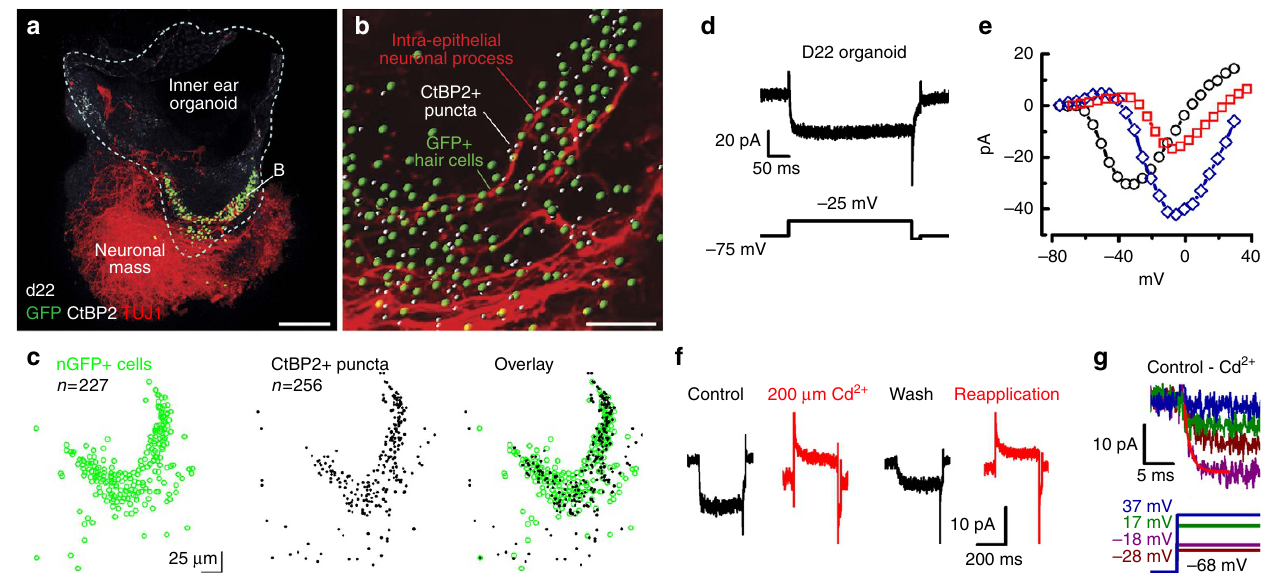
Figure 5 | Atoh1/nGFP organoid hair cells have features that typify vestibular hair cell synapses. ( a , b ) Confocal image of nGFP þ organoid hair cells with CtBP2 þ puncta that colocalize with TUJ1 þ neuronal processes. Scale bars, 50 m m ( a ), 20 m m ( b ). ( c ) Quantitative colocalization analysis of segmented CtBP2 þ punta and nGFP þ nuclei. ( d ) A non-inactivating Ca 2 þ inward current evoked by the voltage step shown below. ( e ) Ca 2 þ current– voltage relations from three organoid hair cells. ( f ) Ca 2 þ currents evoked by a step to (cid:2) 23mV were blocked by 200 m M Cd 2 þ . ( g ) A family of Ca 2 þ currents evoked by the voltage protocol shown below. Subtraction of traces recorded in 200 m M Cd 2 þ from control traces revealed the Ca 2 þ currents shown. Activation kinetics were fit with a single exponential with a time constant of 1.1ms at (cid:2) 25mV (red